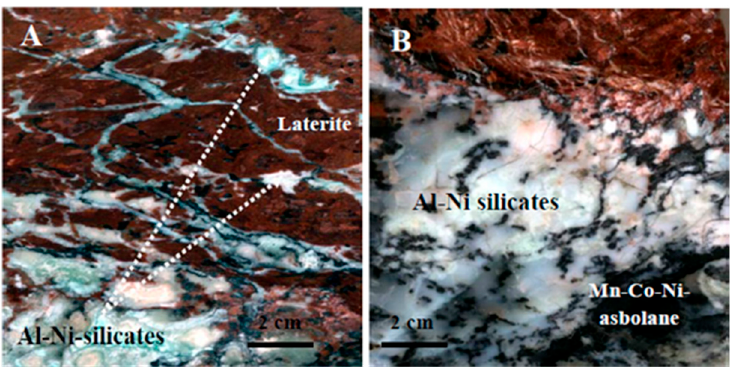
Figure 2. The columnar sections of the studied bauxite laterite profiles at Patitira (Figure 1, red cycle).